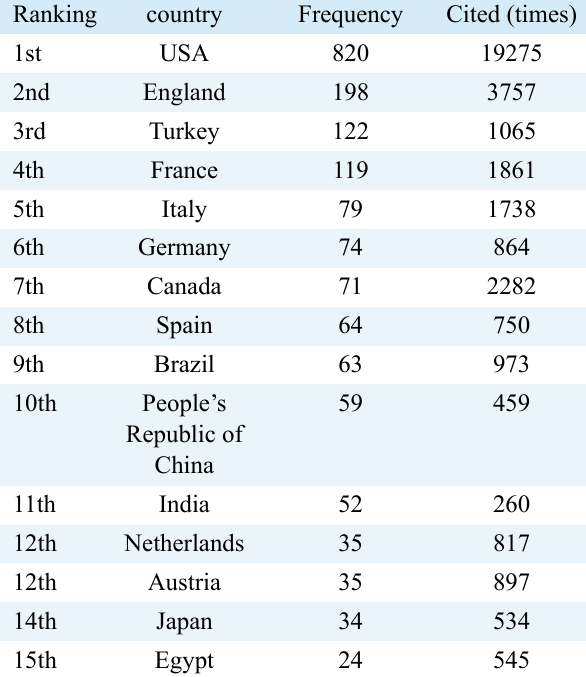
TABLE 3. The top 15 productive and cited country on the research of priapism.